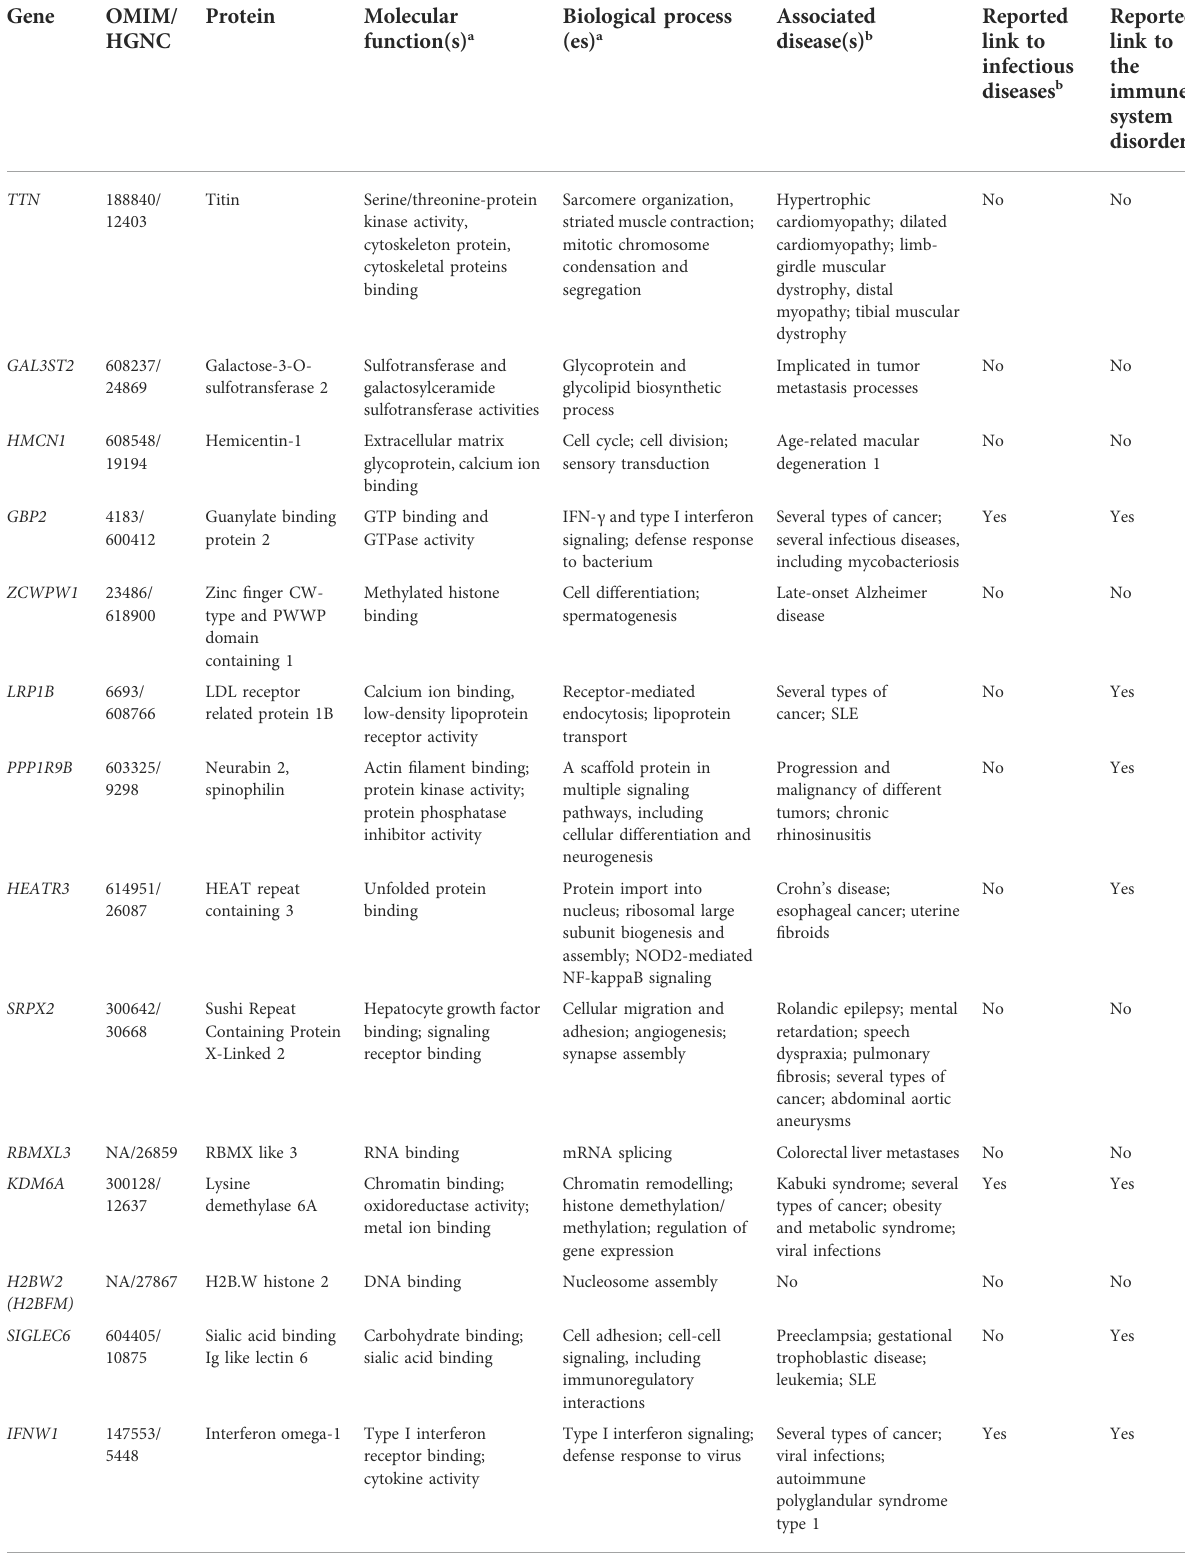
TABLE 4 Summary of the novel genes with rare variants detected in the trio-based WES